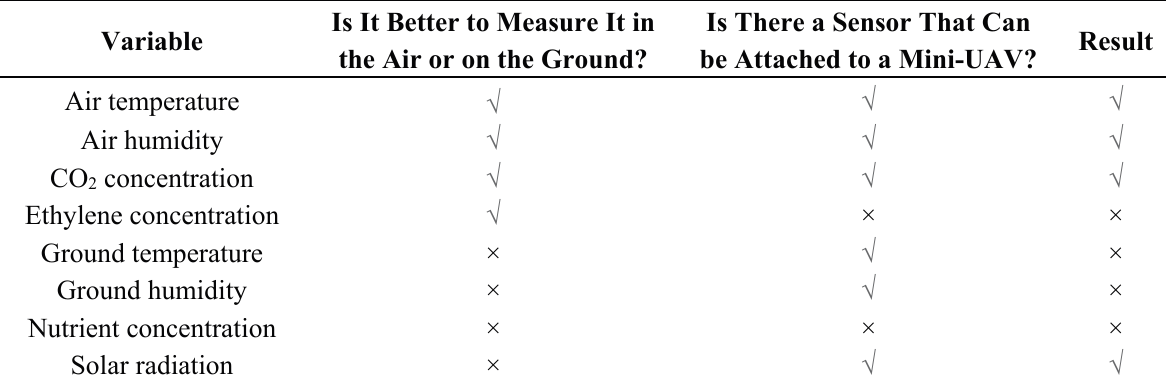
Table 1. Analysis of environmental variables.